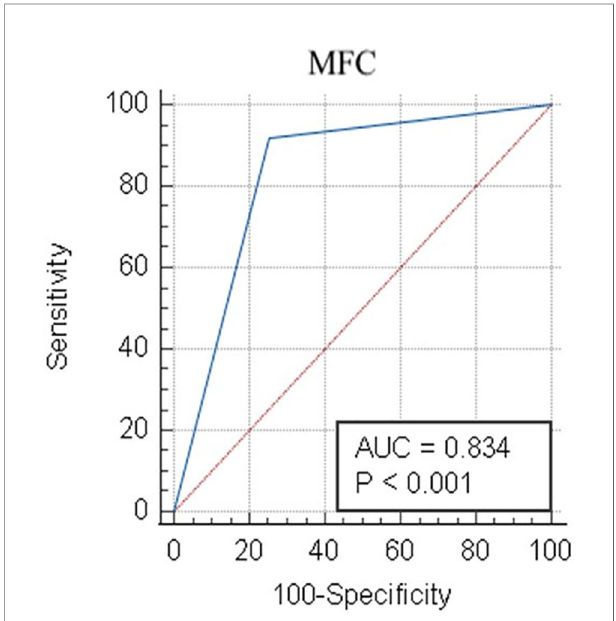
FIGURE 5 | Receiver operator characteristicevaluation ofthe performance of theCompass database-guided analysis for the correct classi fi cation of AML cases. Receiver operating characteristic(ROC) curve (blue line) comparingthe results ofthe Compass database-guided analysiswith those provided by FISH or PCR tests. The red diagonal line represents a random classi fi er. AML, acute myeloid leukemia; MFC, multicolor fl ow cytometry; AUC, area under the